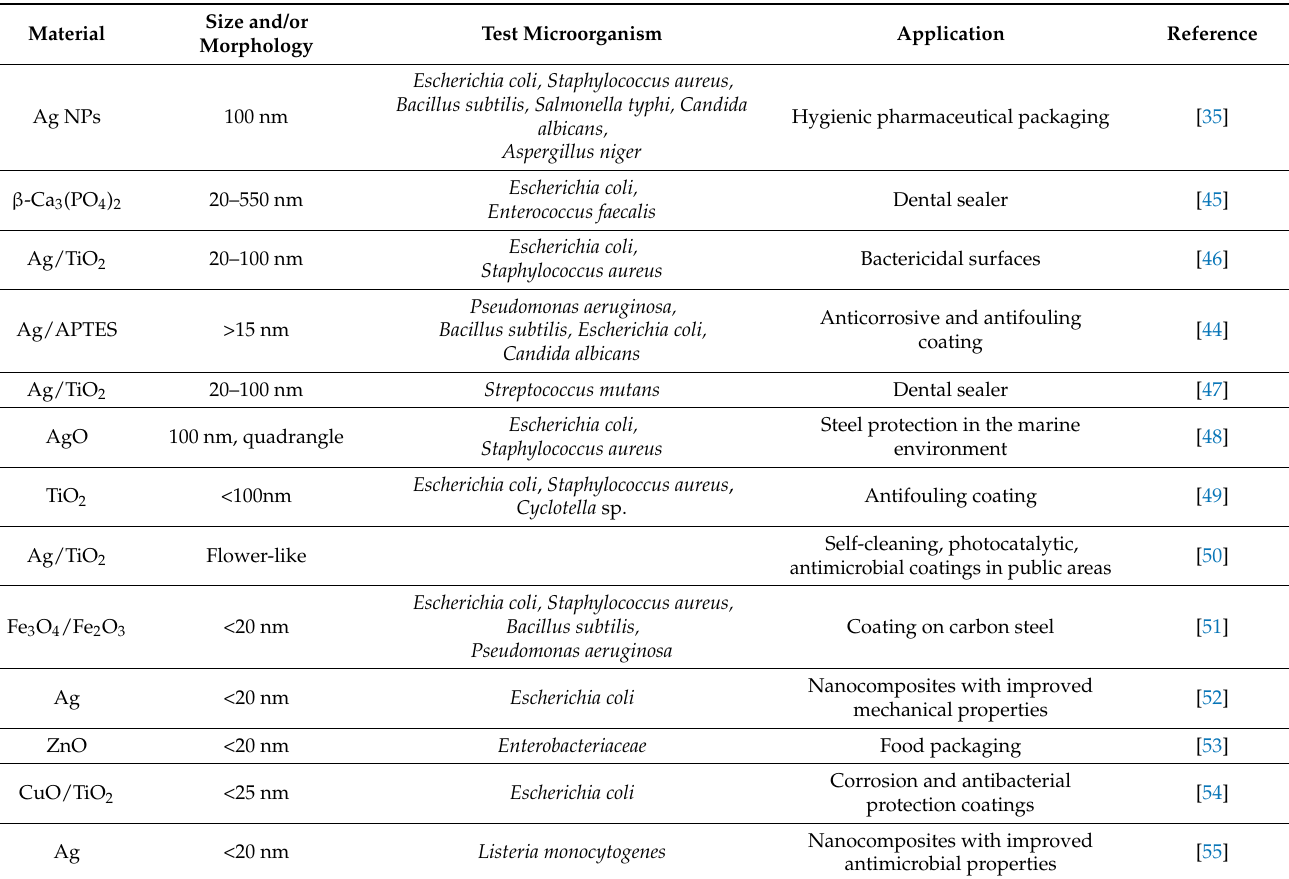
Table 2. Selected inorganic antimicrobial metal-based nano-systems in epoxy